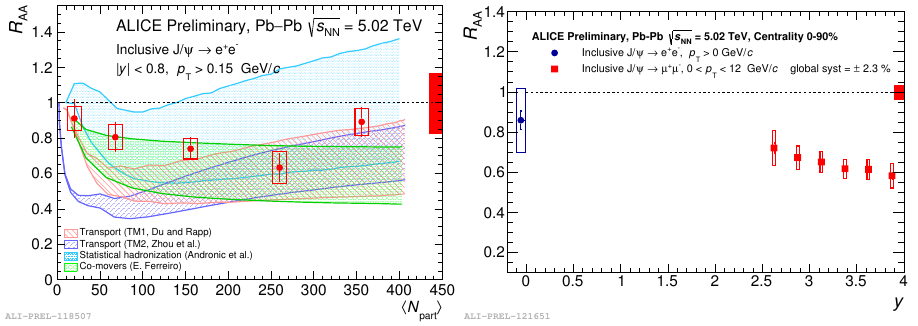
Figure 1. Centrality (left) and rapidity (right) dependent nuclear modification factor. The former is compared to predictions from a thermal model [15], transport models [14, 16, 17] and a comover model [18, 19].